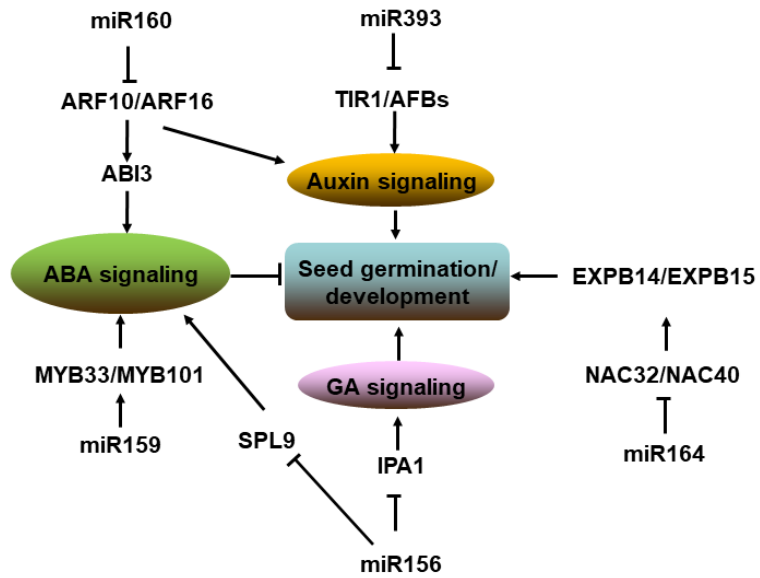
Figure 3. Pathway of miRNAs involved in seed germination and development. MiR156, miR159, miR160, and miR393 targeted transcription factors regulate seed development and germination through auxin, ABA, and GA pathway. Note: → represents positive regulation, and ┤ represents negative regulation.